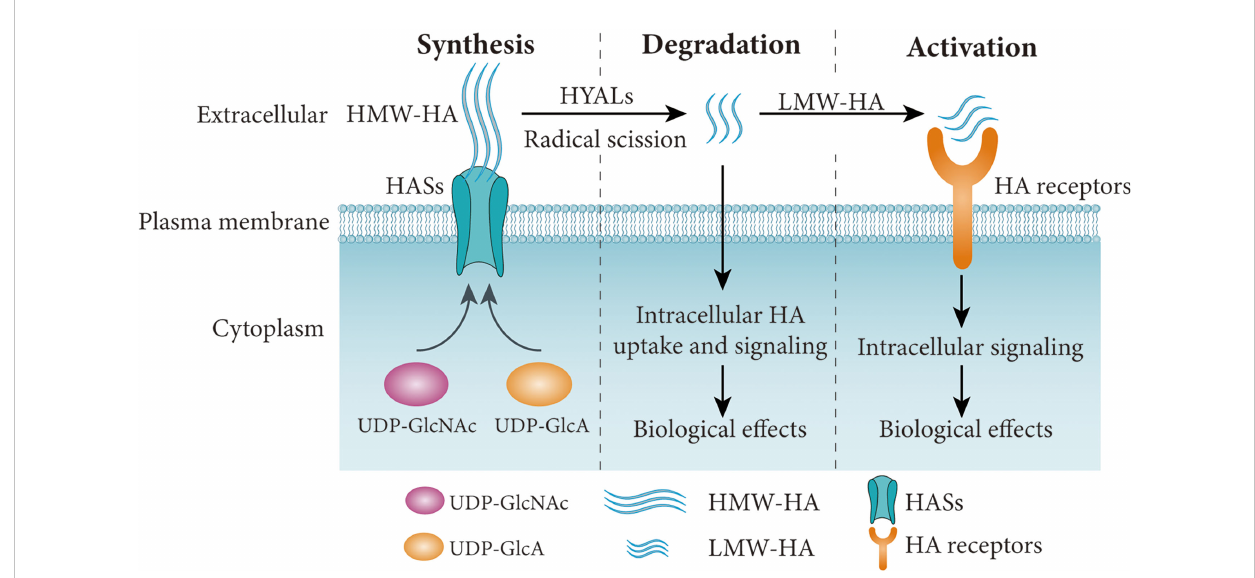
FIGURE 1 Simpli fi ed schematic diagram of HA synthesis, degradation and signaling pathways. HA is synthesized by HASs using UDP-GlcA and UDP-GlcNAc as substrates, and degraded into LMW-HA by HYALs or free radicals. The HA receptors are activated by LMW-HA and involved in various cellular functions. HA, hyaluronan; LMW-HA, low molecular weight HA; HASs, HA synthases; HYALs, hyaluronidases. Figure adapted from Ref (37,